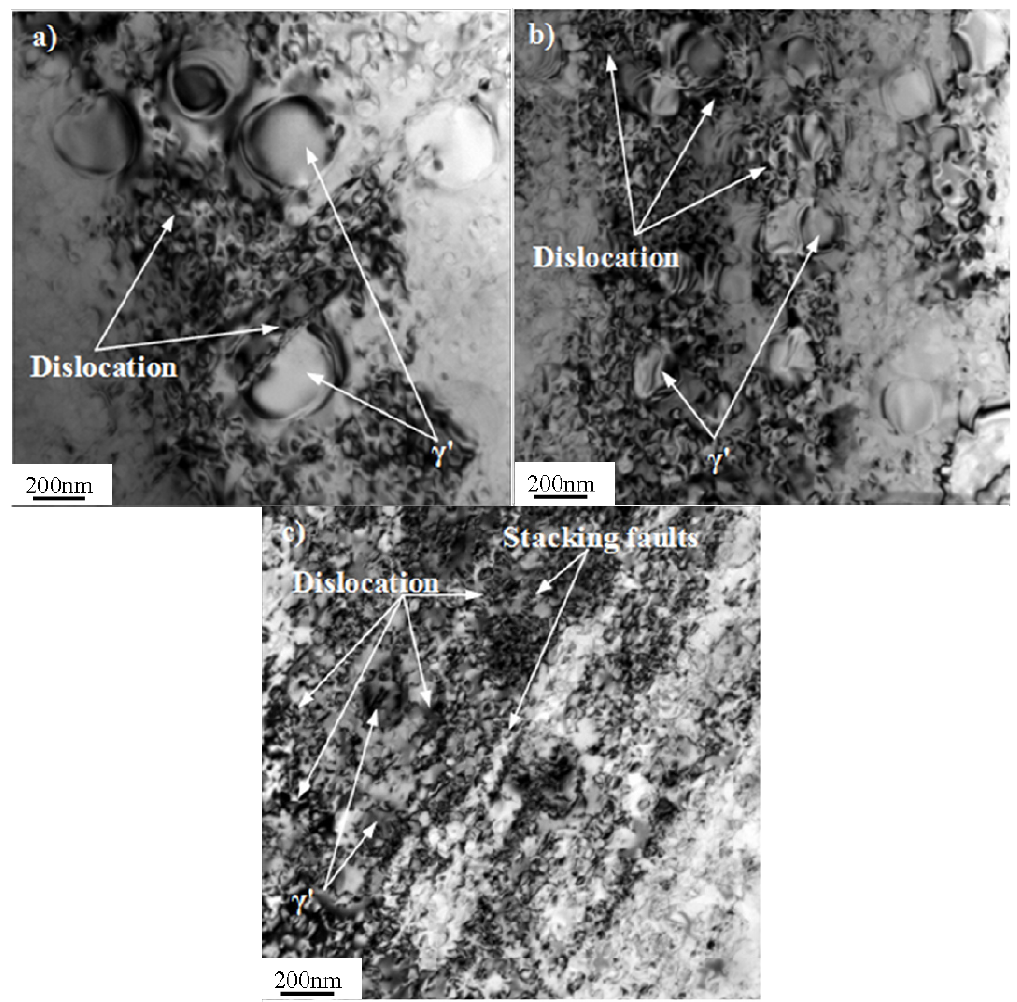
Figure 9. Typical dislocation structures of Pro.I after LCF tests at 650 °C (bright field). ( a ) Δε t /2 = 0.4%, pcum = 3.562; ( b ) Δε t /2 = 0.6%, pcum = 1.952; ( c ) Δε t /2 = 0.8%, pcum = 1.012.